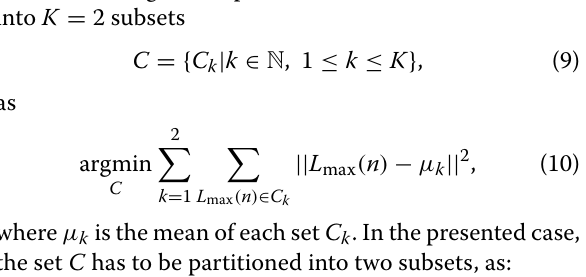
energy clusters L max ( n ) , between the two groups of sim- ulated signals, suggesting that precise classification could be obtained by the application of the proposed criterion. To validate the proposed classification criterion we have applied it to measured data, Fig. 12. In Fig. 12, no over- lapping of the two data sets (valid and faulty) can be observed.